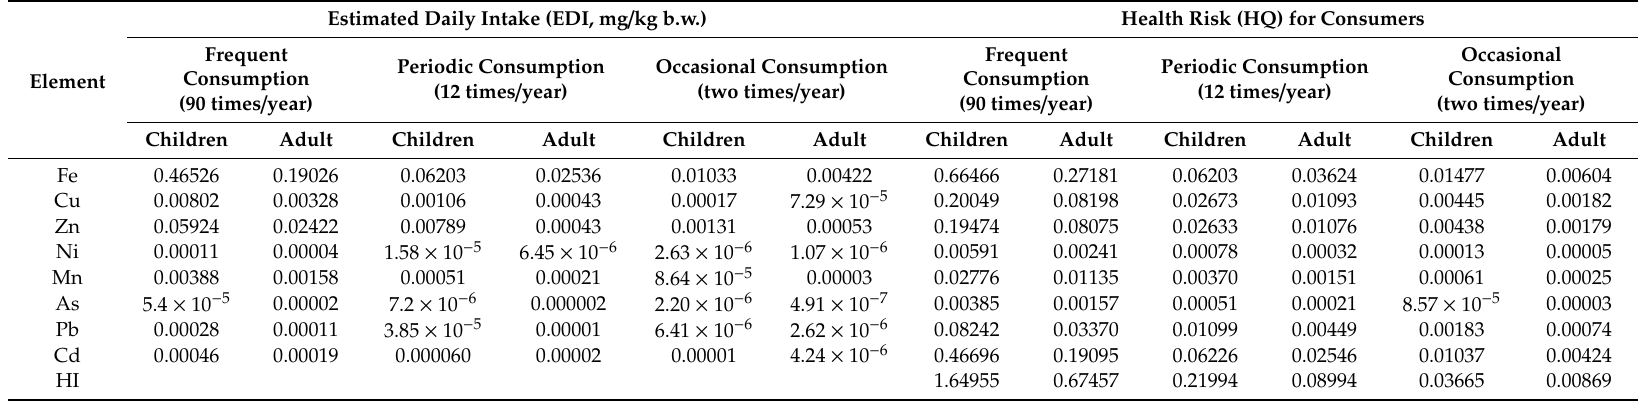
Table 5. Association of the estimated daily intake of elements, health risk (HQ), and hazard index (HI) with consumption of liver of the wild boar from group I.